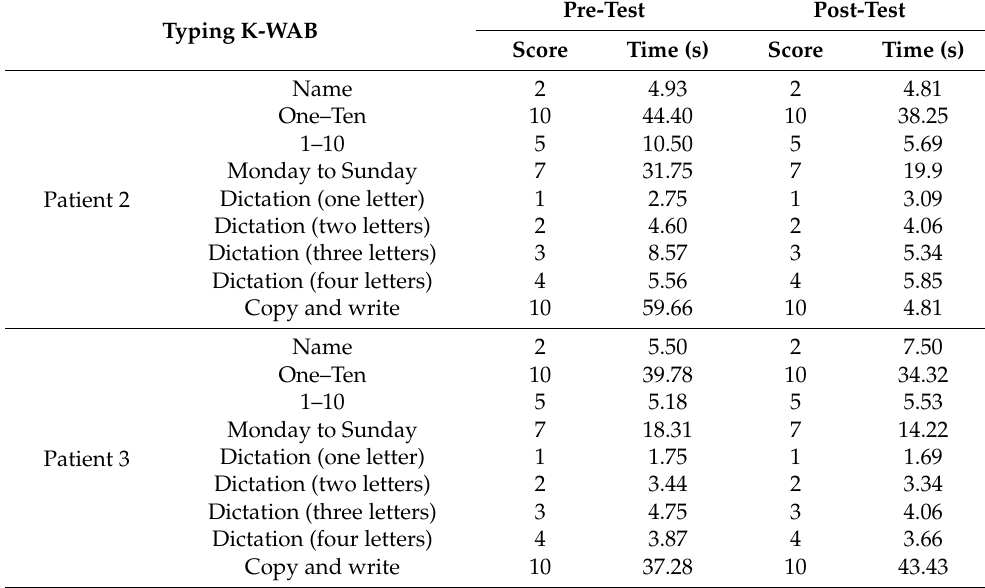
Table 2. Results based on the typing K-WAB